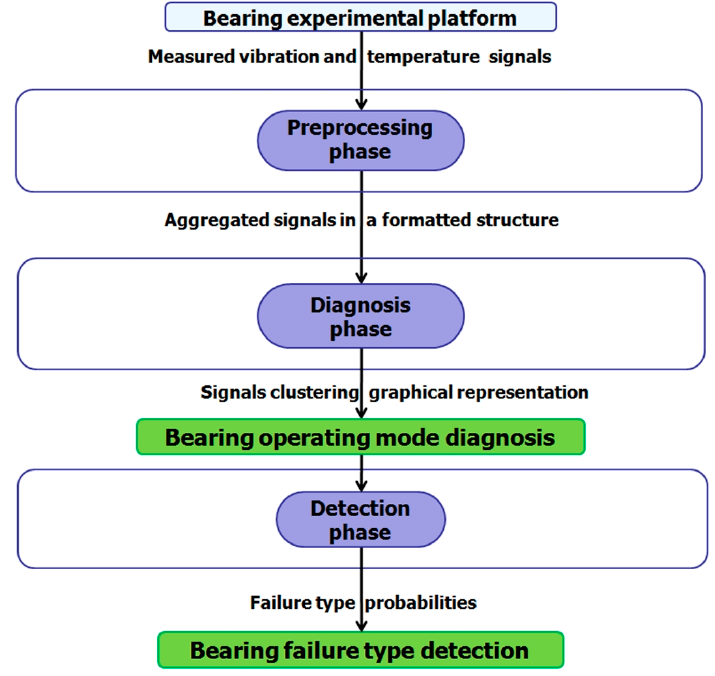
Figure 1. Workflow of the three-phase approach.